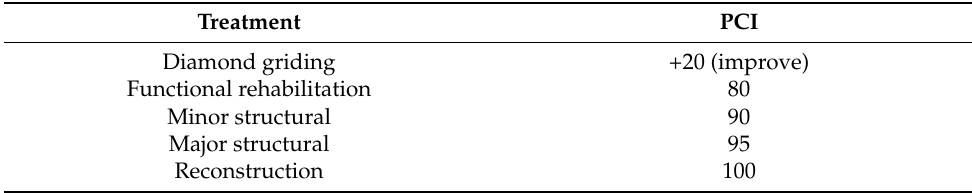
Table 6. Reset values for PCC pavements.